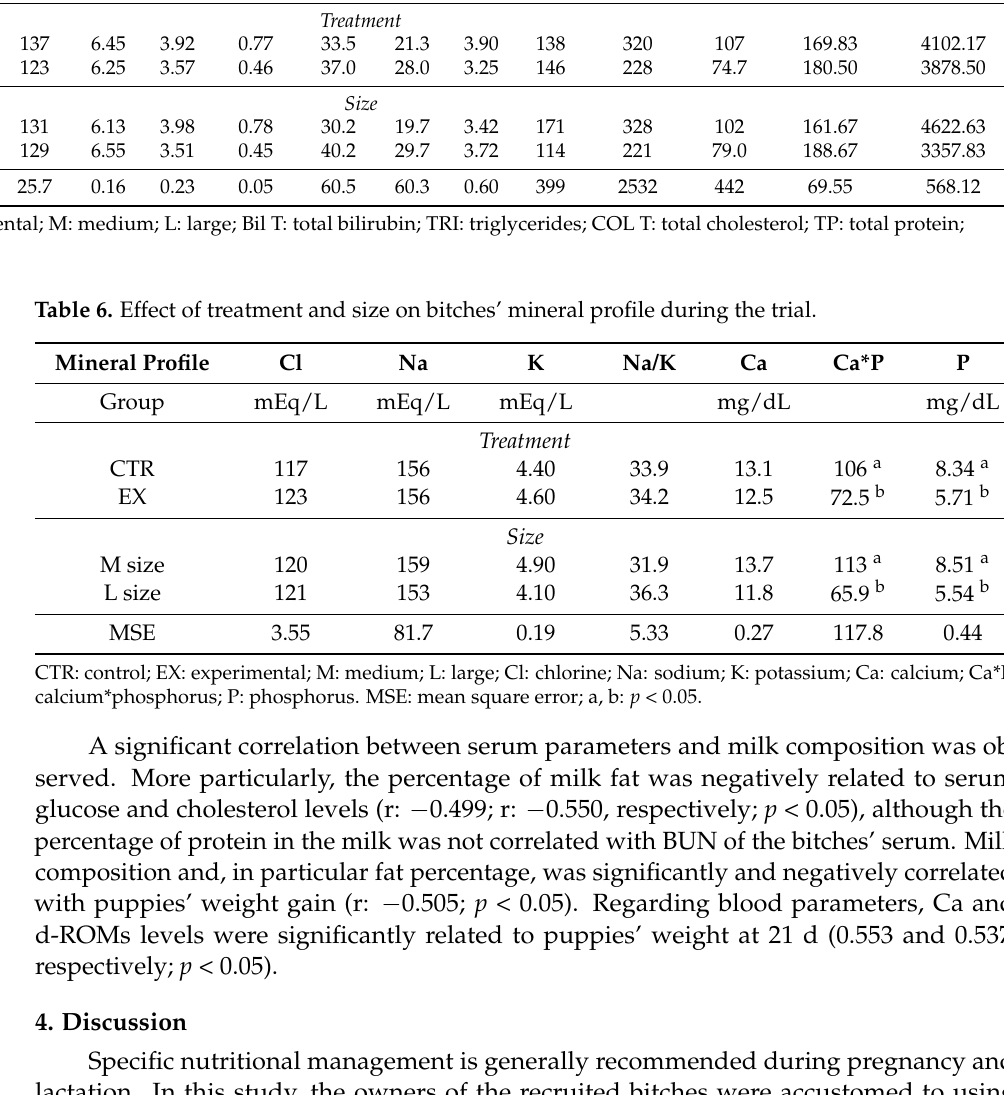
Table 5. Effect of treatment and size on bitches’ hematic profile during the trial. Hematic Profile